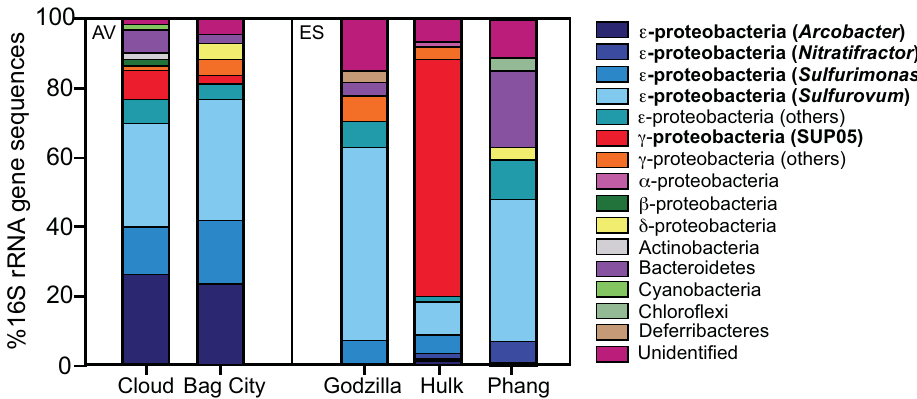
Fig. 4. Composition of the 16S rRNA gene clone libraries recovered from DNA extracted from 5 DNA samples from diffuse vent fluids at Axial Volcano (AV) and the Endeavour Segment (ES) on the Juan de Fuca Ridge: Cloud (AV07-CP), Bag City (AV08-BC), Hulk (ES08-H), Godzilla (ES08-G) and Phang (ES09-P) (see Table 2). SUP05 and other potential NO − reducing bacteria are in bold. Note that only a limited 3 number of clones were sequenced at each site. See Table 2 for more information about DNA samples and 16S rRNA gene clone libraries.